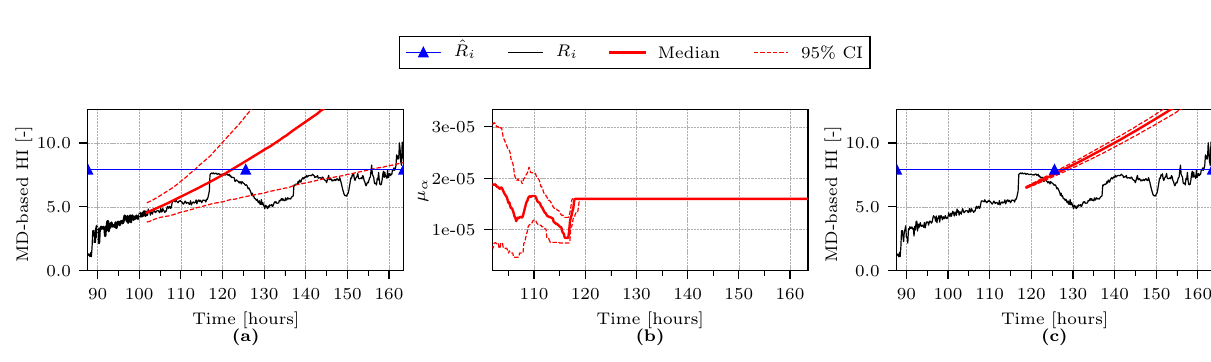
with marked part as 1 converges. α